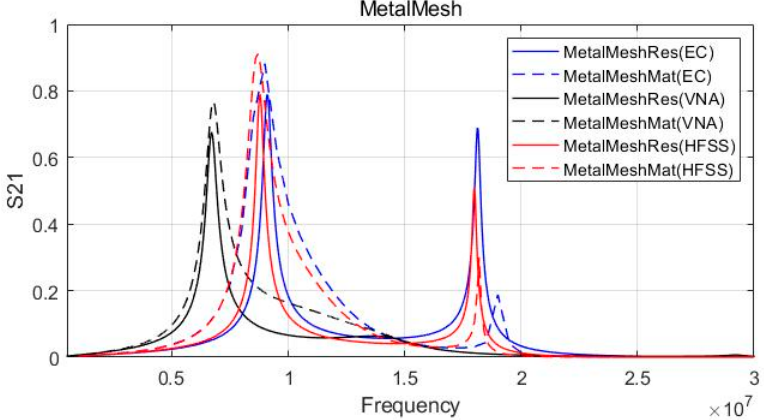
Figure 10. Experimental and simulation result (metal mesh).